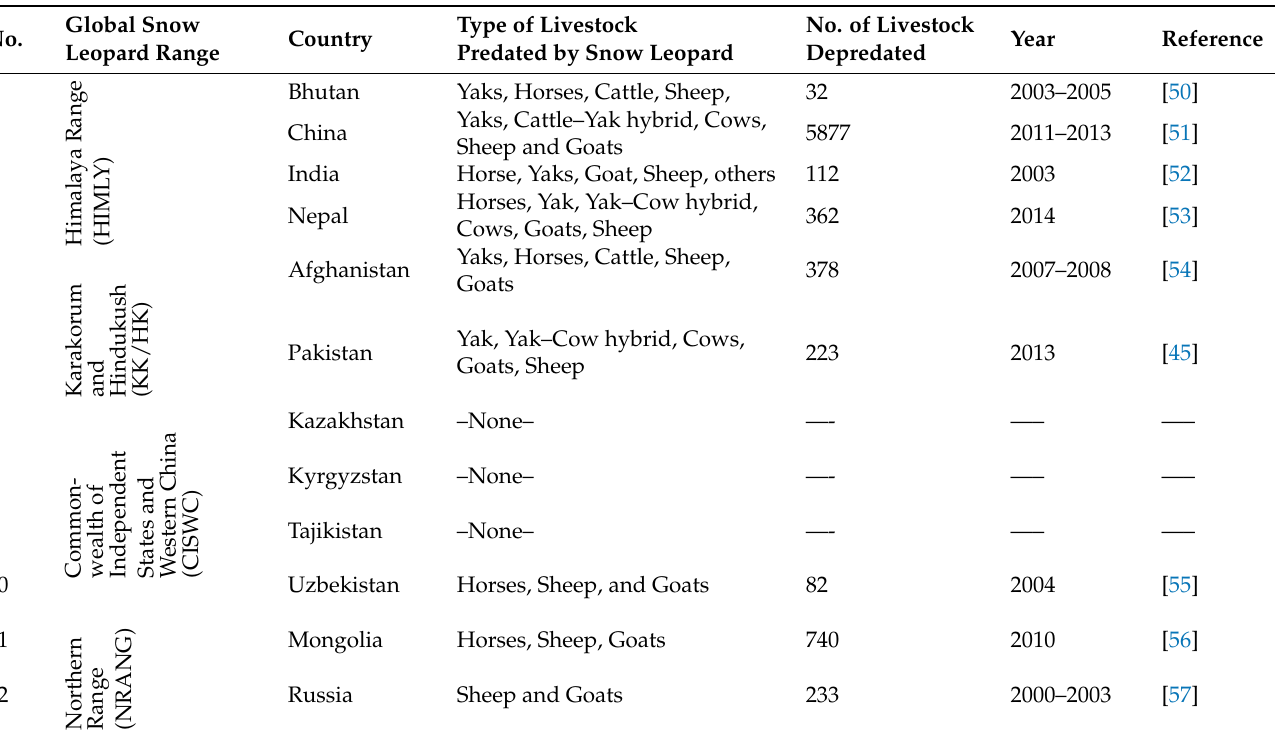
Table 1. The details of livestock type and number predated by snow leopards in different ranges and